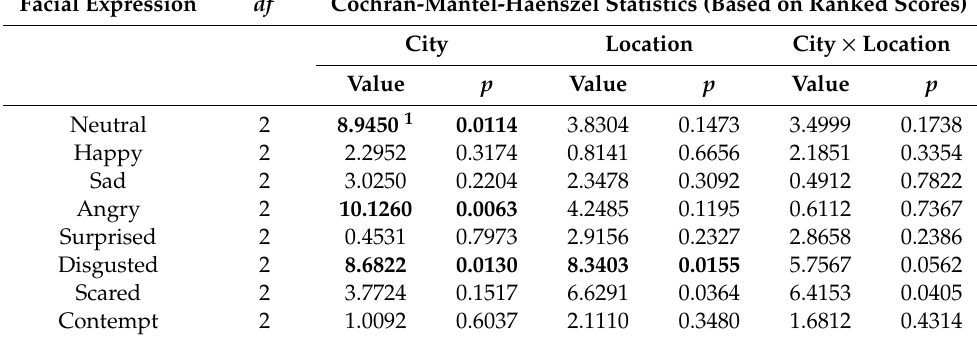
Table 2. Summary statistics by Friedman’s chi-square test on ranked scores for neutral, happy, sad, angry, surprised, disgusted, scared, and contemptuous facial expressions from visitors stratified by variants of different cities (City), park locations (Location), and their interaction (City × Location).